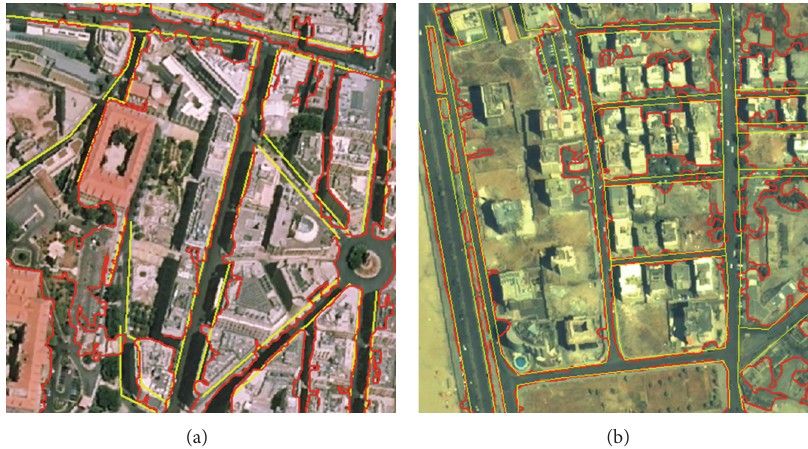
Figure 6: Road networks: manually digitized (yellow) and extracted by the new model (red).